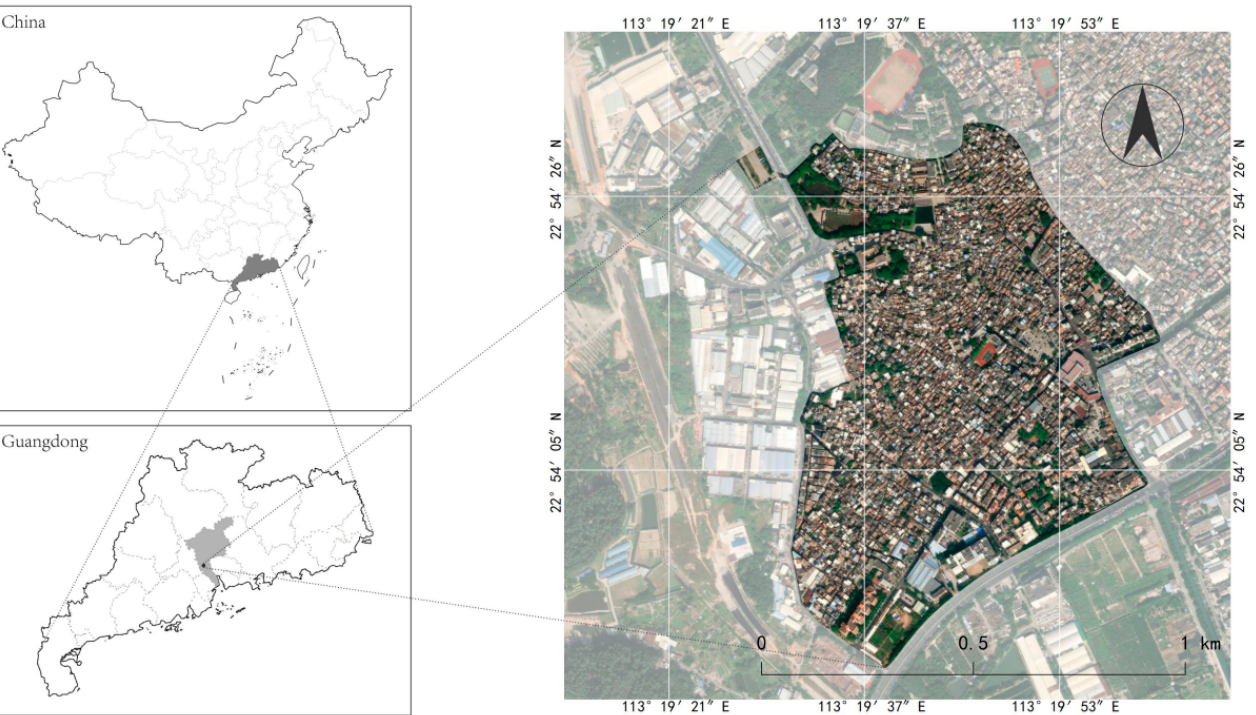
Figure 1. Location of Shawan Ancient Town in Guangzhou, Guangdong. (Source: the authors). The Shawan Ancient town is composed of the He Clan, the Wang Clan, and other clans, and its layout is centered on Liugengtang. The rest of the buildings expand out- ward in a fan shape. The streets run vertically from north to south, forming cold al- leys. It builds a crisscross pattern with three main horizontal streets, namely, Wenlinfang, Guanxiangli–Guanzhaili, and Anning West Street. Anning West Street in the south and the nearby Daxiangyong Road constitute a group of residential buildings with